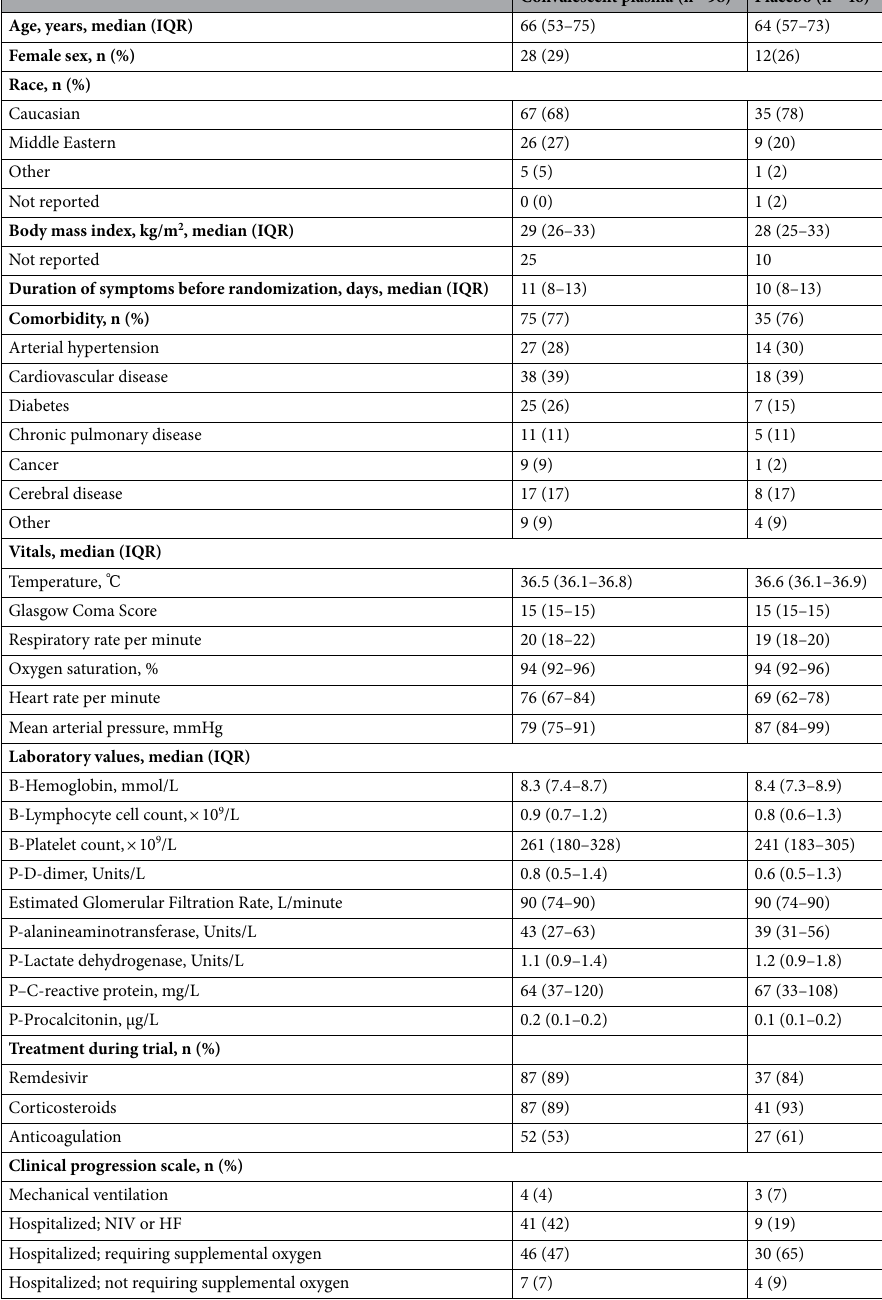
Table 1. Baseline characteristics of patients included in the modified intention to treat analysis. IQR interquartile range, NIV non-invasive ventilation, HF high-flow, P plasma, B